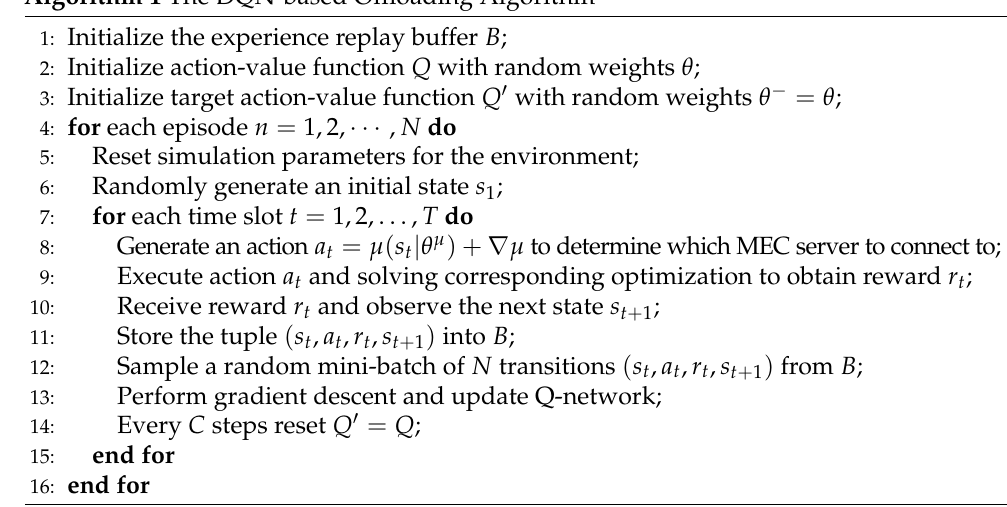
Figure 5. The structure of the DQN-based offloading algorithm. Algorithm 1 The DQN-based Offloading